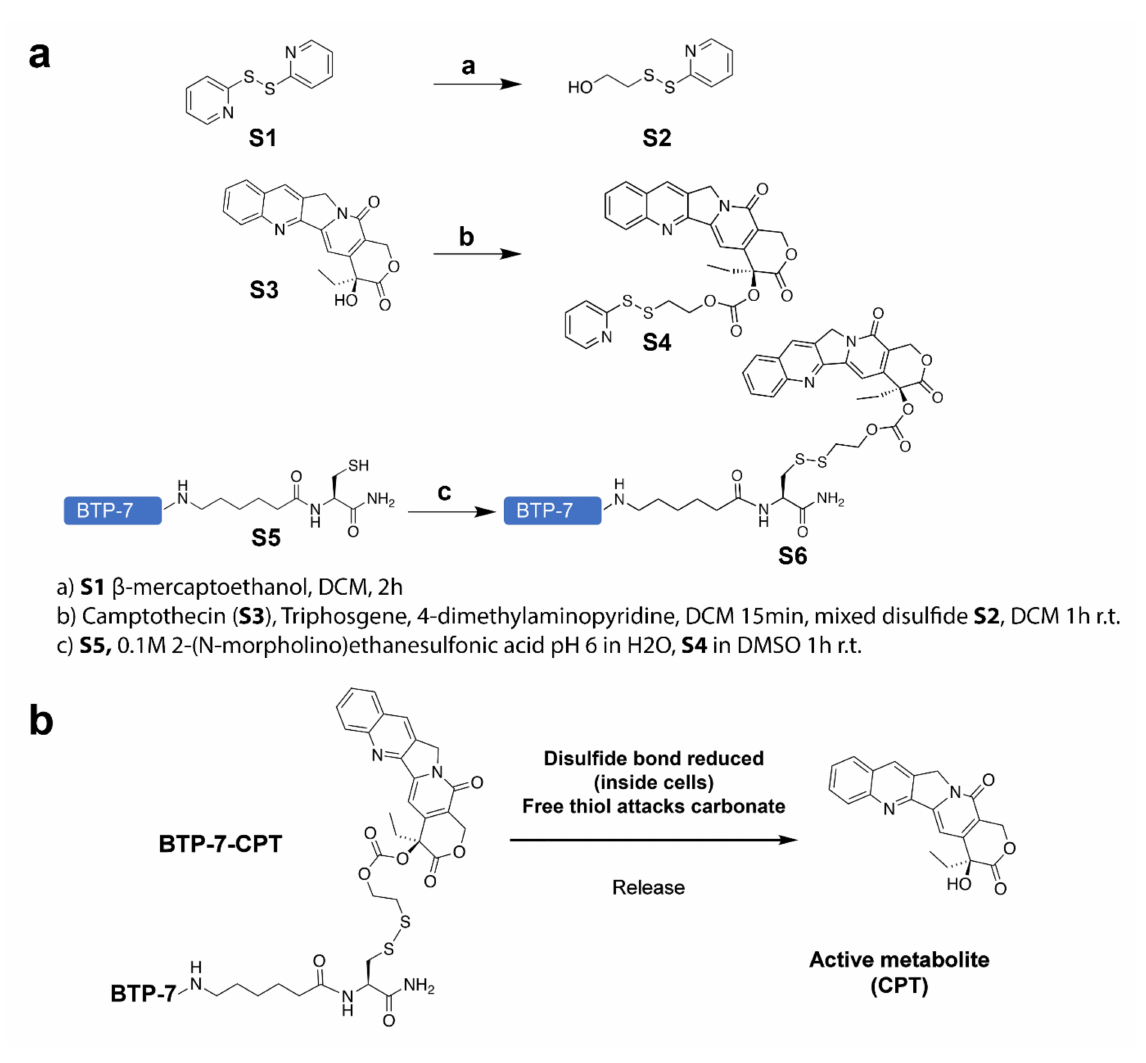
Figure 1. ( a ) Chemical synthesis workflow showing the conjugation of BTP-7 to camptothecin (CPT) (details listed in the SI); and ( b ) cleavage mechanism to release active CPT drug upon cell